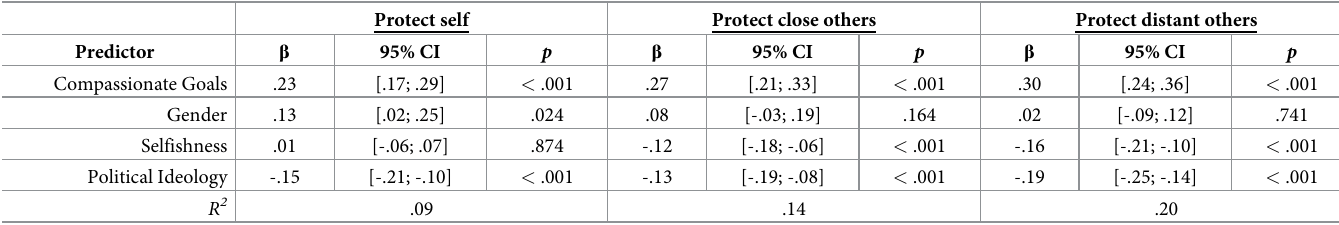
Table 14. Coefficients from multiple regression models predicting reasons for COVID-19 health behaviors across three